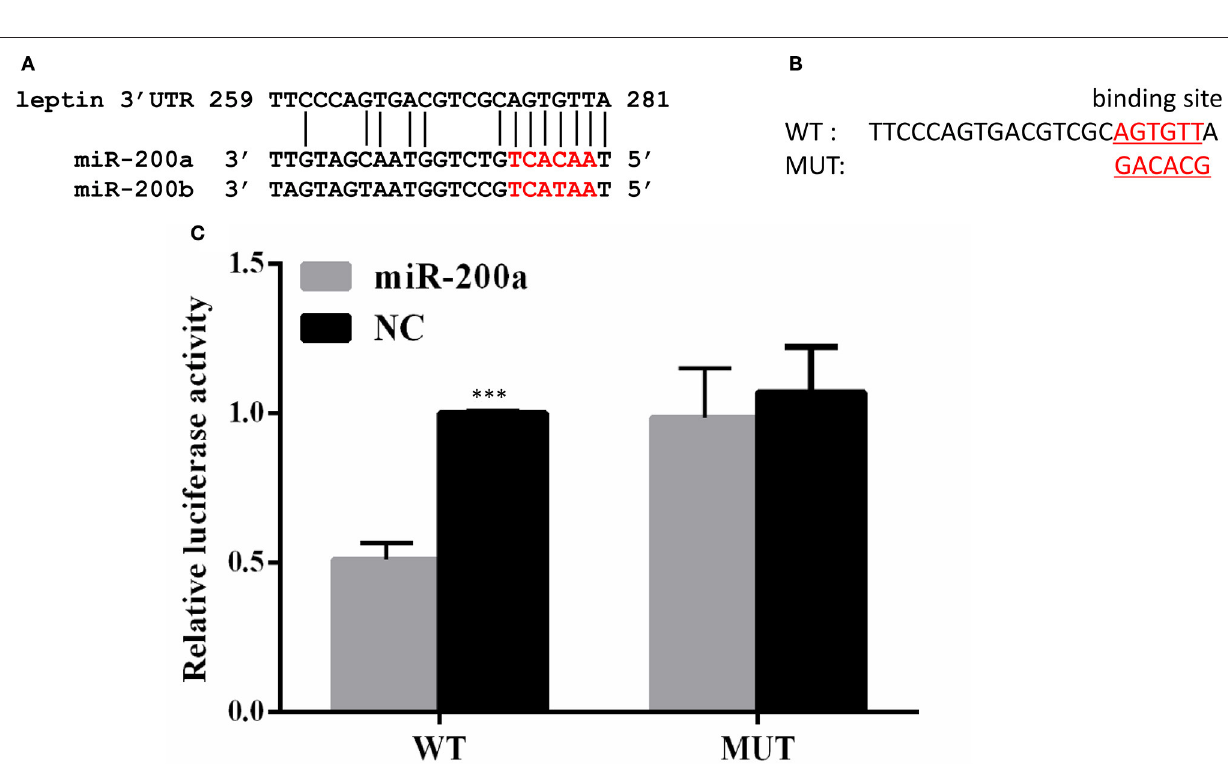
significantly repressed the luciferase activity of leptin 3 ′ UTR- pmirGLO, whereas mutation in the binding site abrogated this repression ( Figure 3C